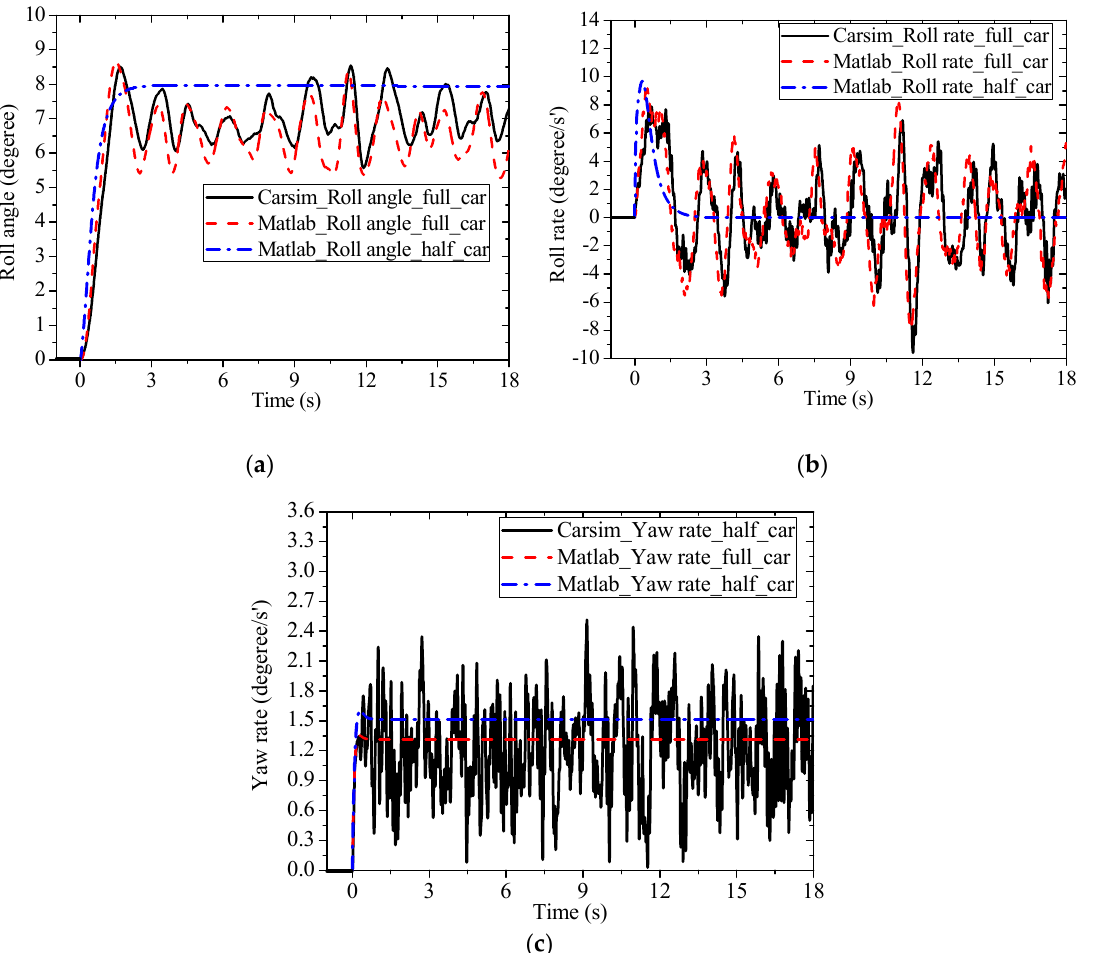
Figure 11. Results with road Level ISO- C excitation (steering wheel angle was 10 ◦ at 80 km/h). ( a ) Roll angle, ( b ) Roll rate, ( c ) Yaw rate.